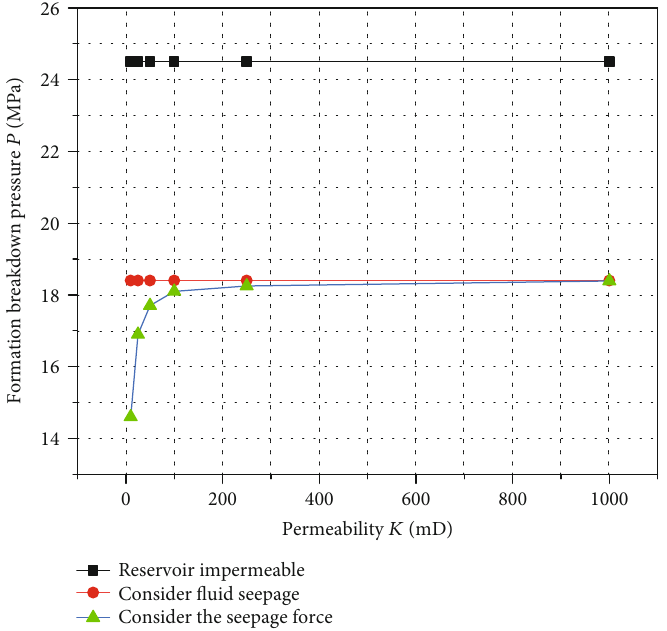
Figure 12: Relationship between formation breakdown pressure and permeability for three cases.